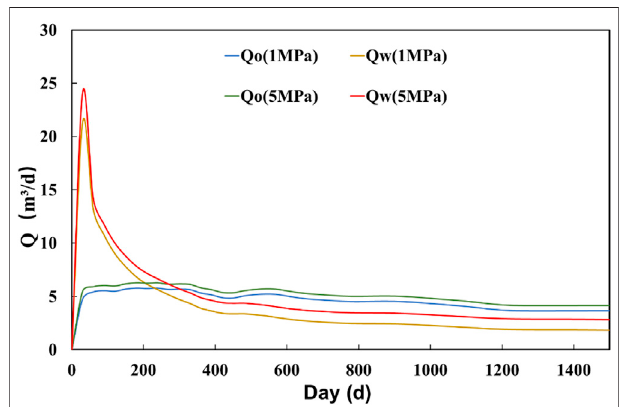
FIGURE 10 | Variation rule of daily liquid production with days of development and production under1MPa capillary force and 5 MPa capillary